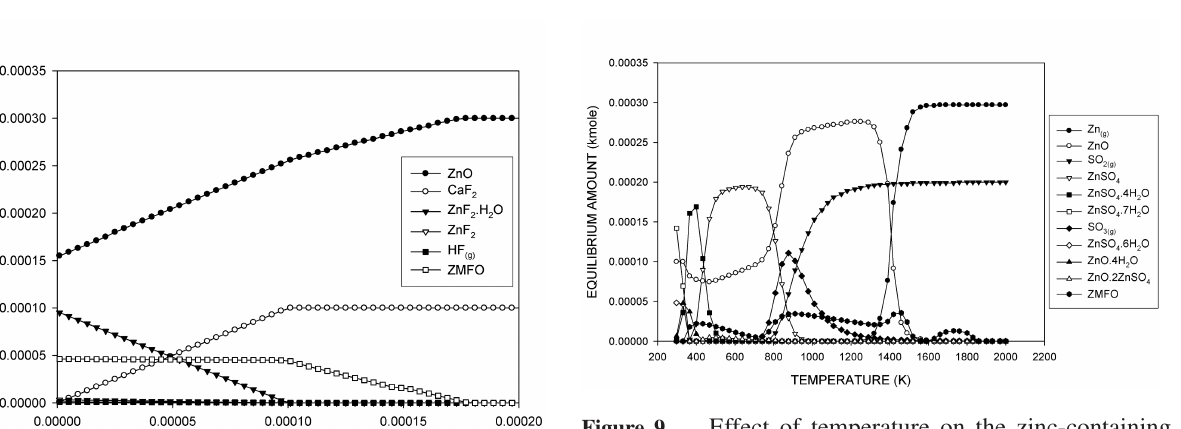
Figure 9. Effect of temperature on the zinc-containing species and sulphur dioxide and sulphur trioxide for the Zn- Fe-Mn-O-C-H-S